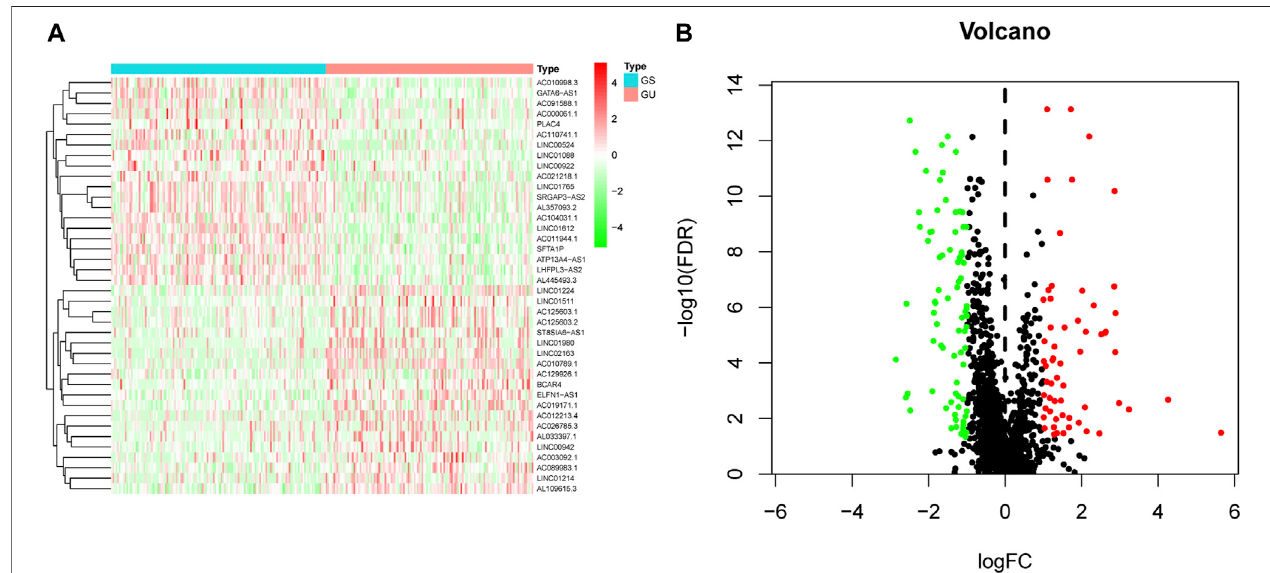
FIGURE 1 | Heatmap and volcano plot of differentially expressed lncRNAs in LUAC. (A) Heatmap of differentially expressed lncRNAs in the GS-like group versus the GU-like group. The upregulated lncRNAs are denoted in red, and the downregulated lncRNAs are indicated in green; (B) Volcano plot of differentially expressed lncRNAs in the GS-like group versus the GU-like group. The upregulated lncRNAs are denoted in red, the downregulated lncRNAs are indicated in green, and the unaltered lncRNAs are denoted in black.